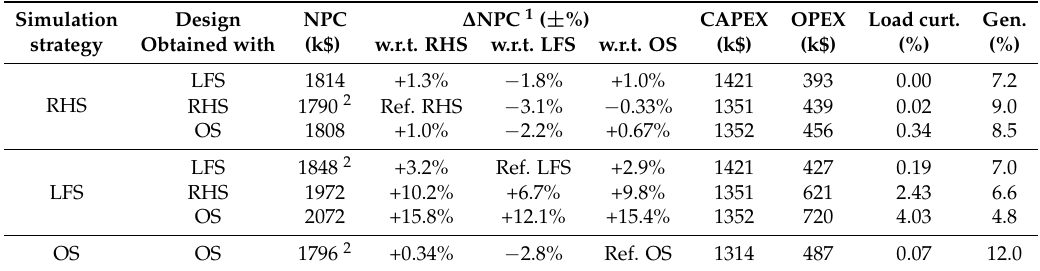
Table 3. Simulations of the mini-grid designed with an operating strategy-LFS, RHS or OS-and operated with another strategy (LFS or